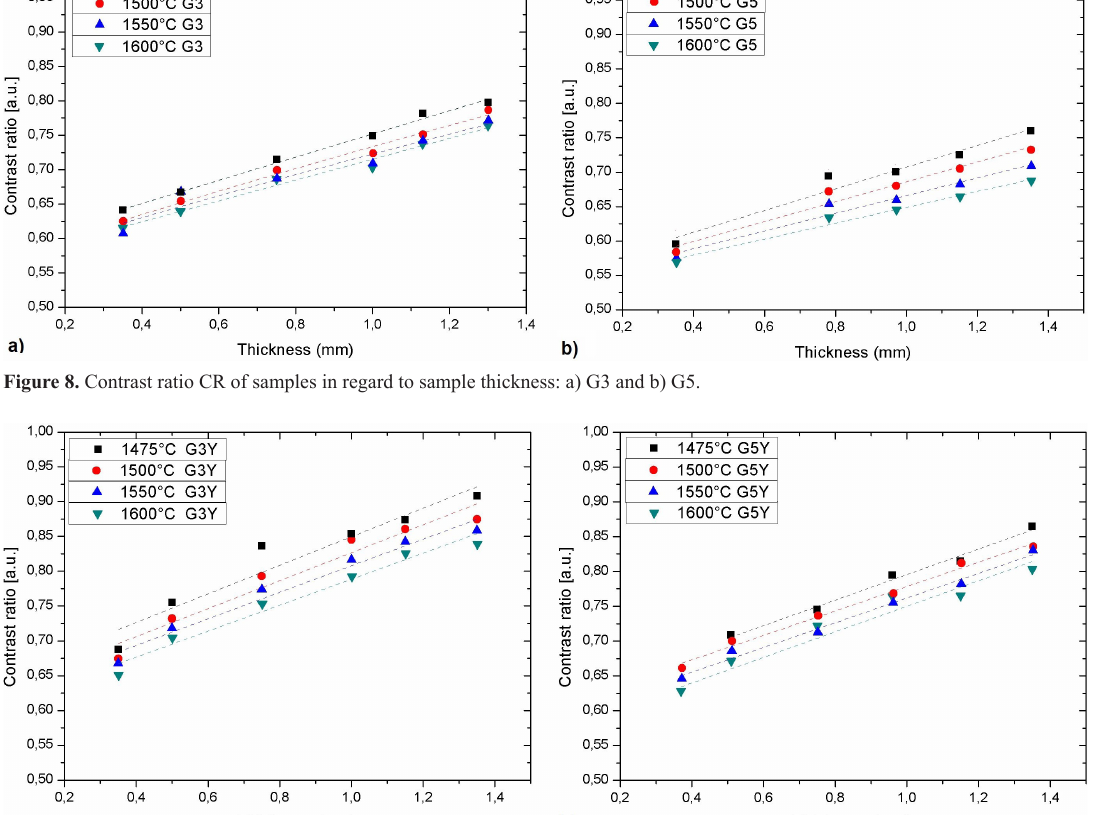
Figure 9. Contrast ratio of samples containing Fe